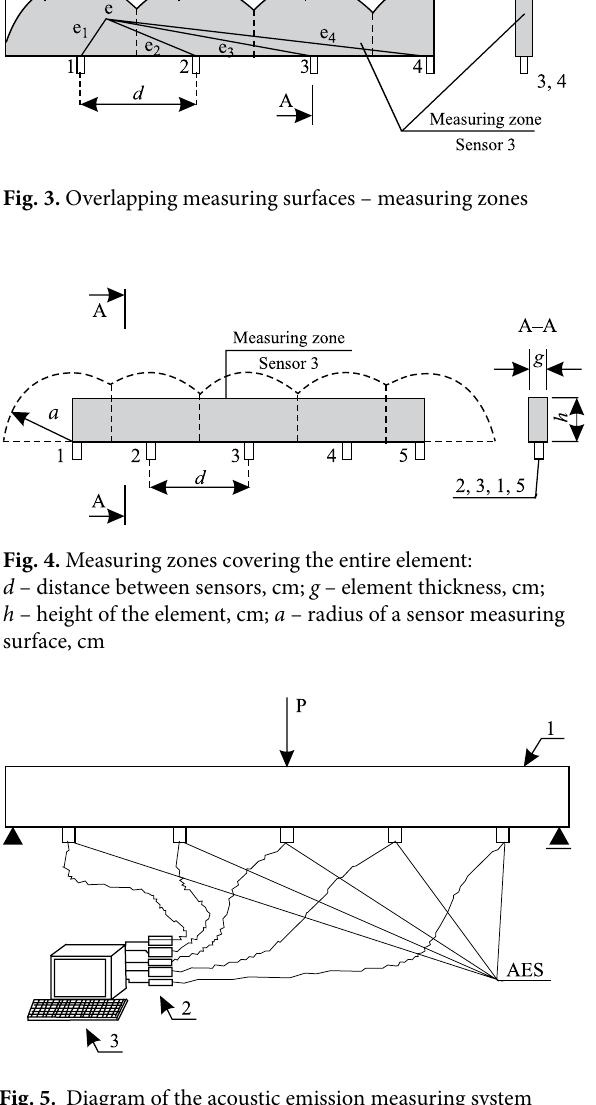
Fig. 5. Diagram of the acoustic emission measuring